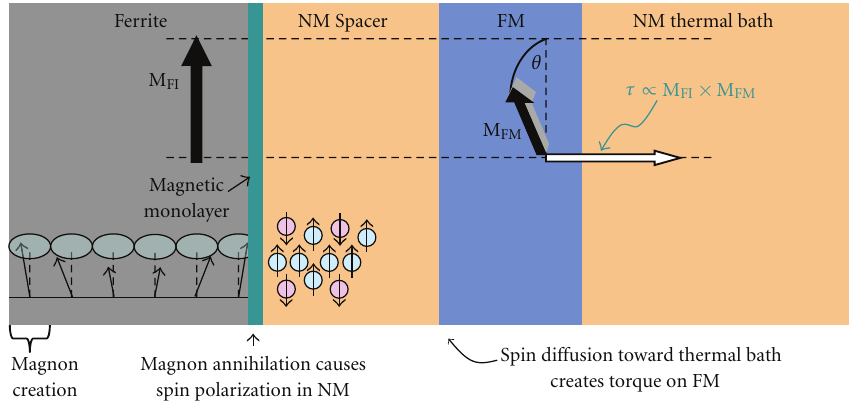
Figure 1: Magnon-induced spin transfer torque (MISTT) ala Slonczewski [10]. Magnons are created thermally in the magnetic insulator. Though these magnons are annihilated at the ferrite-normal metal (NM) interface (which contains a monolayer of ferromagnet metal atoms), their spin momentum is transferred to the electrons in the NM spacer. This creates spin accumulation in the NM, which then di ff uses toward the NM thermal bath. The spin accumulation current density (more precisely, its time derivative) at the Py interface imposes a torque on the Py magnetization if its magnetization M FM is at some angle relative to the ferrite’s magnetization, M FI .